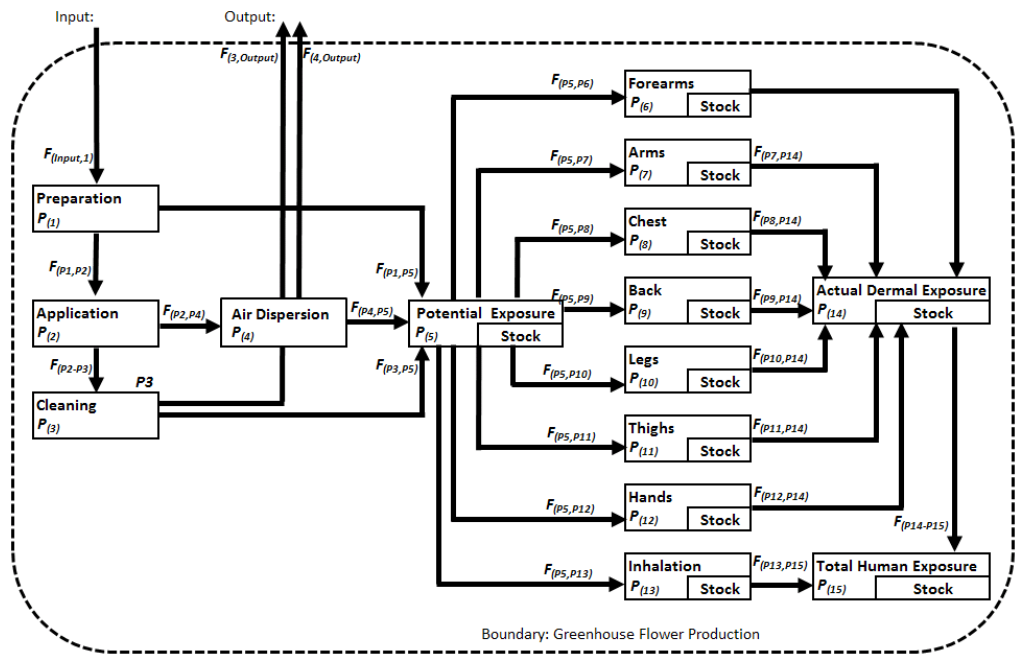
Figure 1. Pesticide flow analysis for the floriculture system (P: Processes, F: